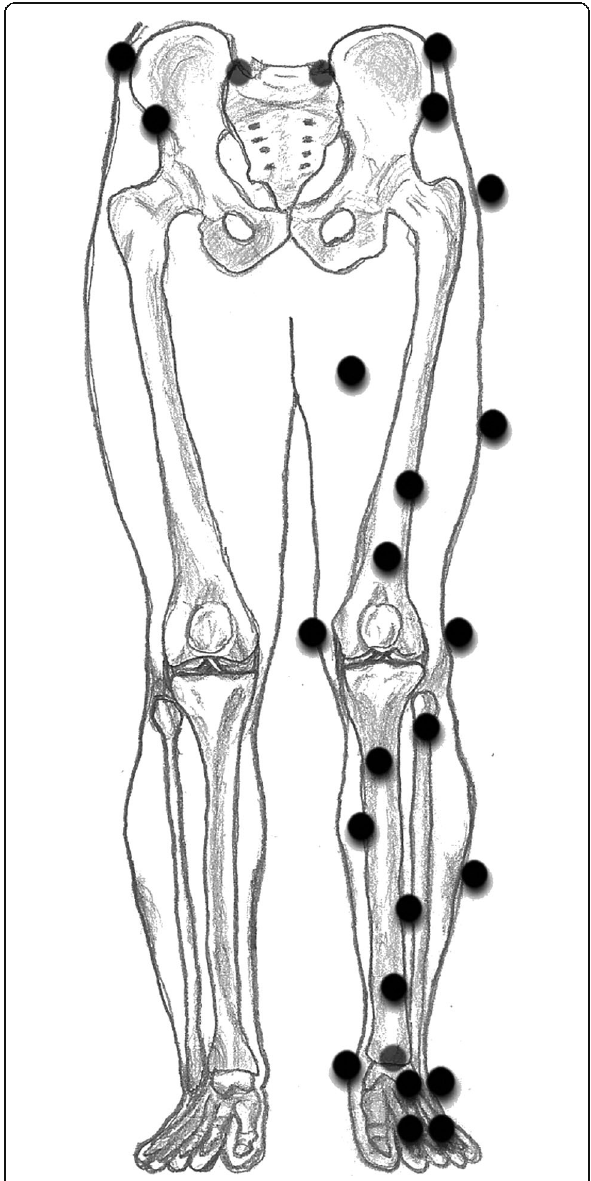
Fig. 1 Marker placement. Markers were attached on the right and left anterior and posterior superior iliac spine, the right and left iliac crest, the greater trochanter, the medial and lateral epicondyles of the knee, the medial and lateral malleoli of the ankle, the heel, anterior of the talus bone and the first and fifth metatarsophalangeal joints. Besides, two additional markers were attached to the pelvis, two to the thigh, and six additional markers were attached to the shank (adapted from Boeth et al.